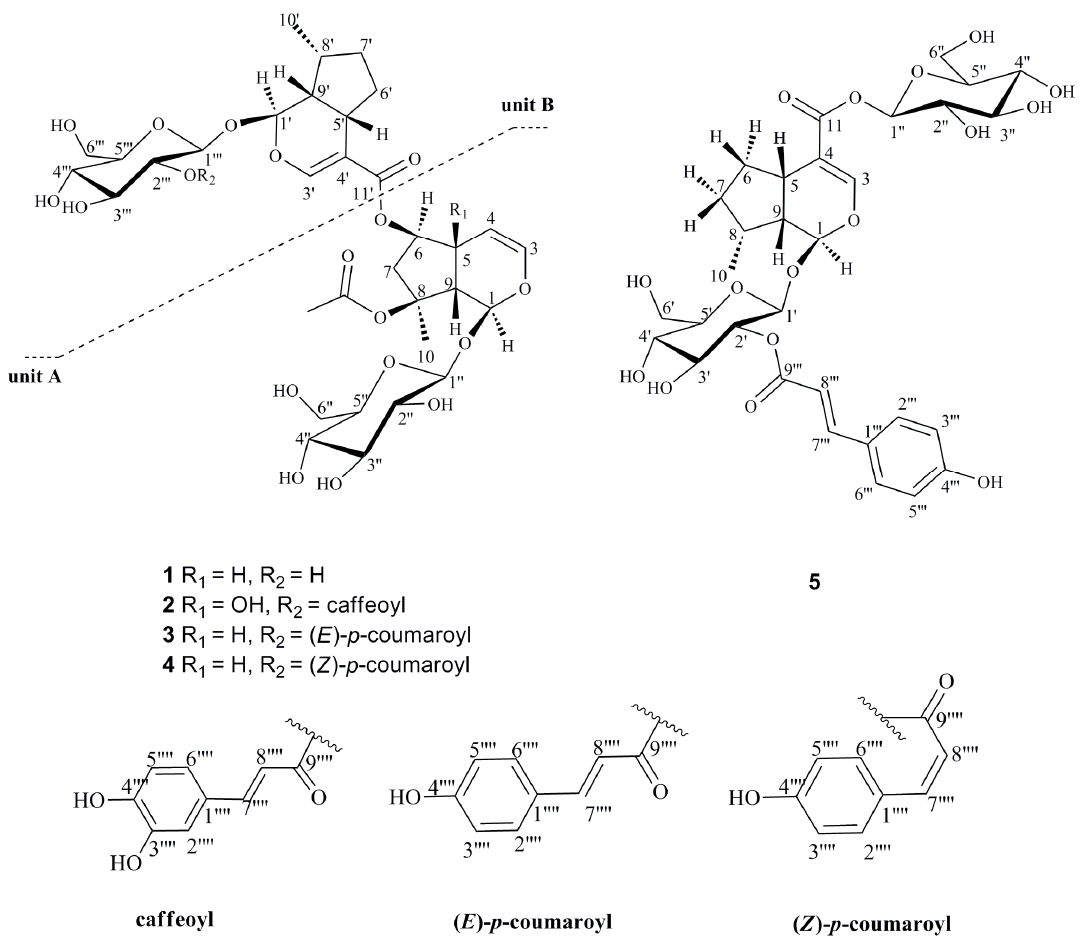
Figure 1. Chemical structures of compounds 1 – 5 .